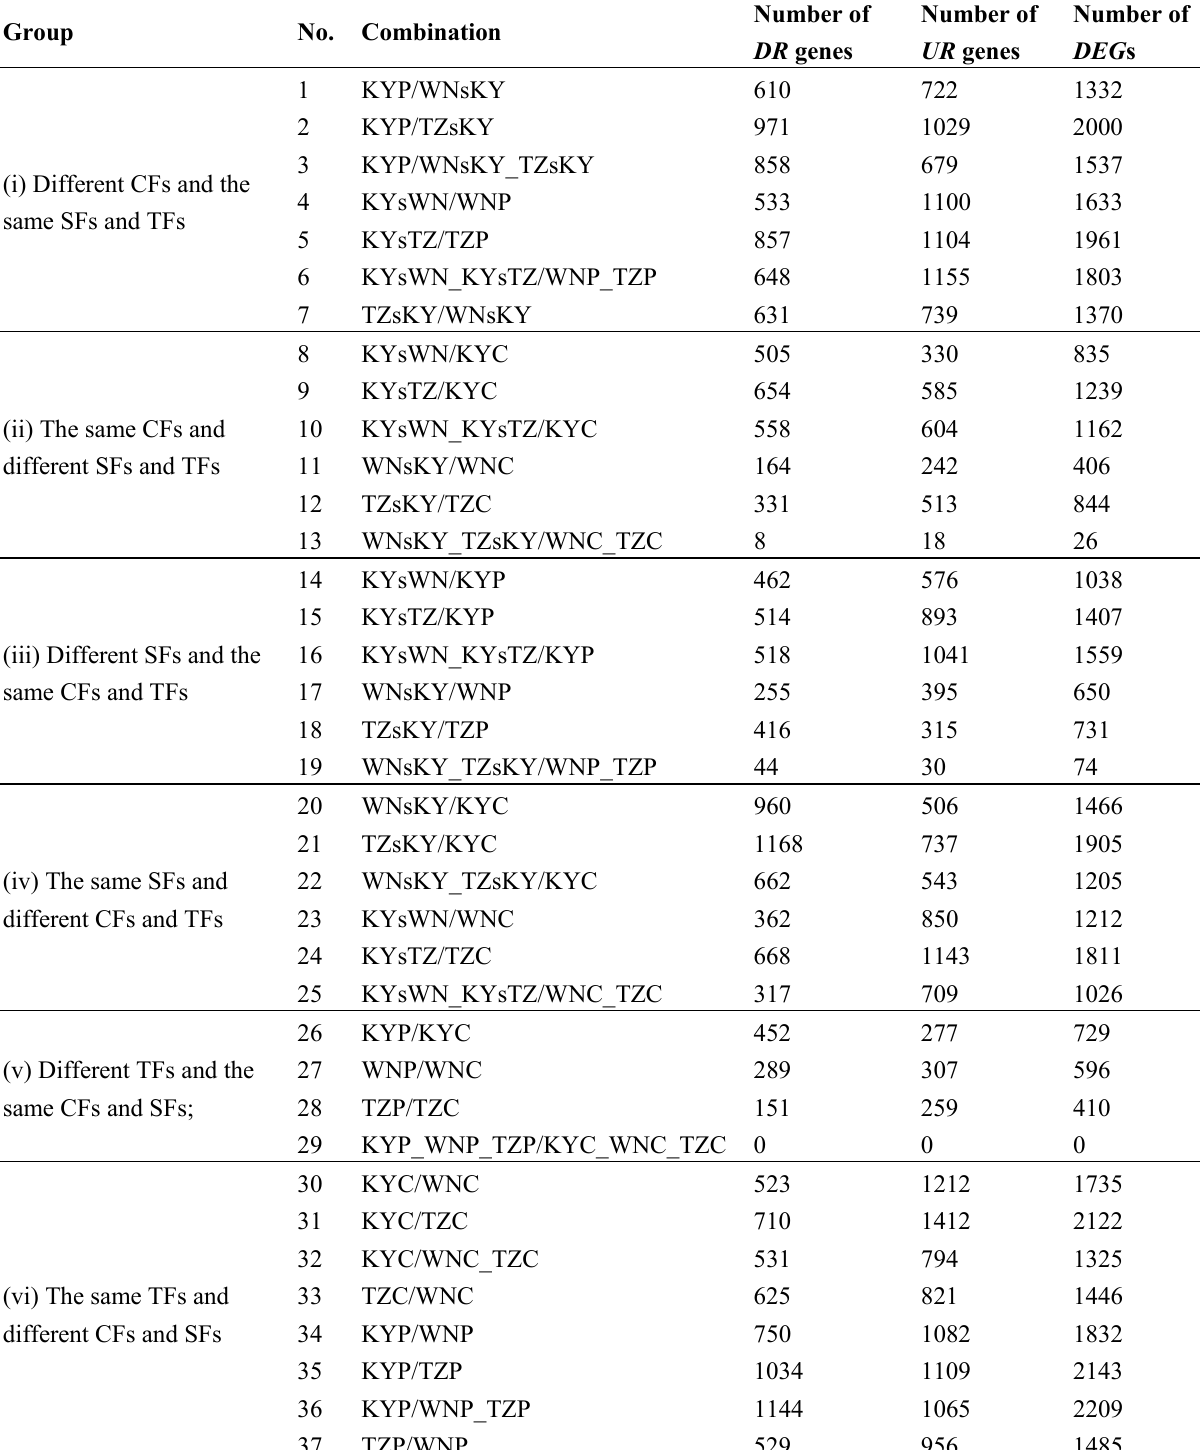
Table 2. The number of DEGs in tobacco leaves affected by different CFs, SFs, and/or TFs. Group No. Combination